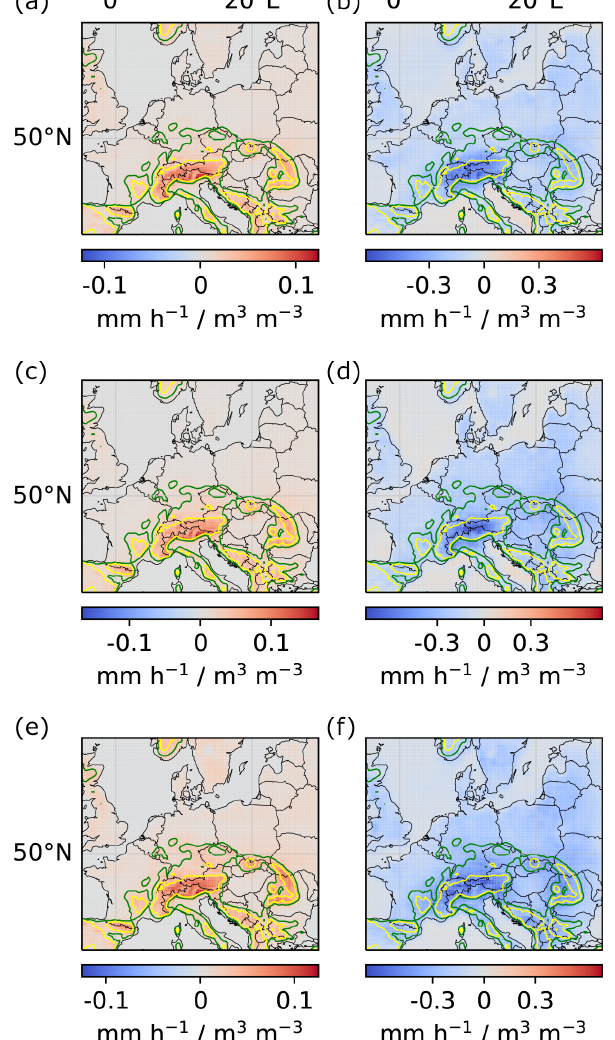
Figure A2. Local and regional soil-moisture–precipitation cou- plings for models trained only on data from June, July and August, respectively. (a, c, e) Local couplings. (b, d, f) Regional couplings. (a, b) Model trained on data from June. (c, d) Model trained on data from July. (e, f) Model trained on data from August.